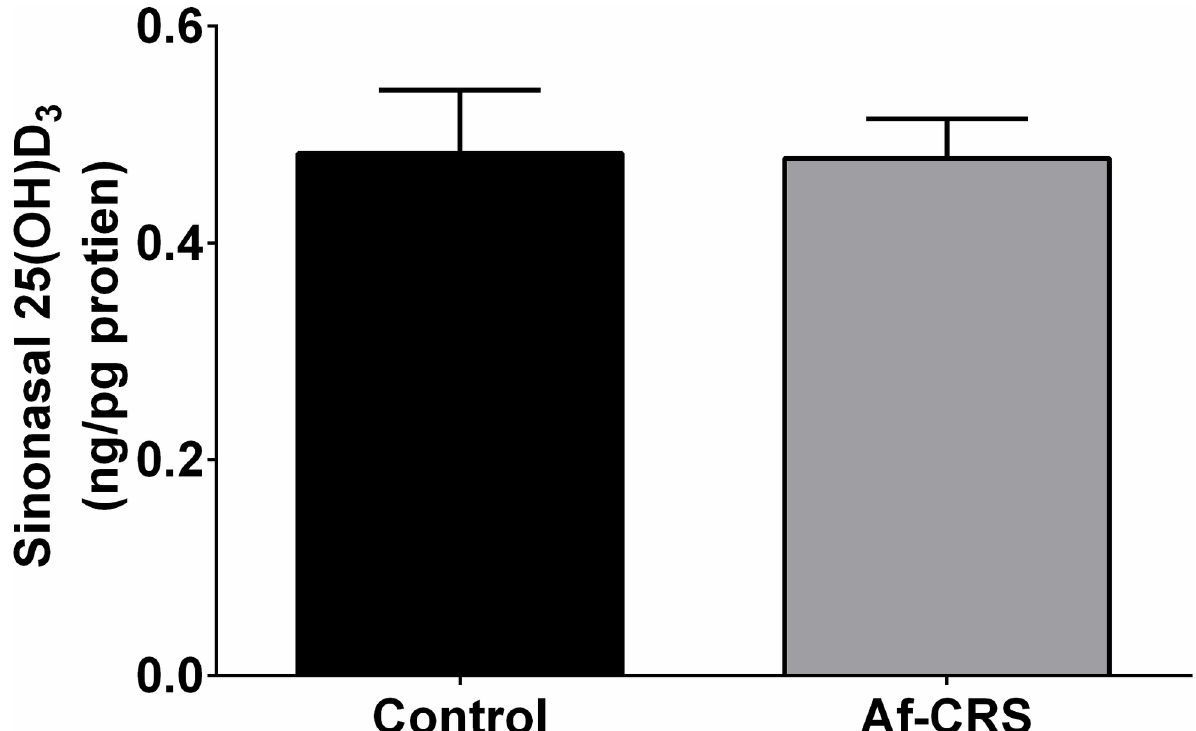
Fig 5. Af-CRS is not associated with sinonasal reductions in 25(OH)D 3 . Sinonasal levels of 25(OH)D 3 were measuredby ELISA and results normalized to total protein concentration. Both groups were fed control diet and were systemically 25(OH)D3 sufficient. N = 3 mice/